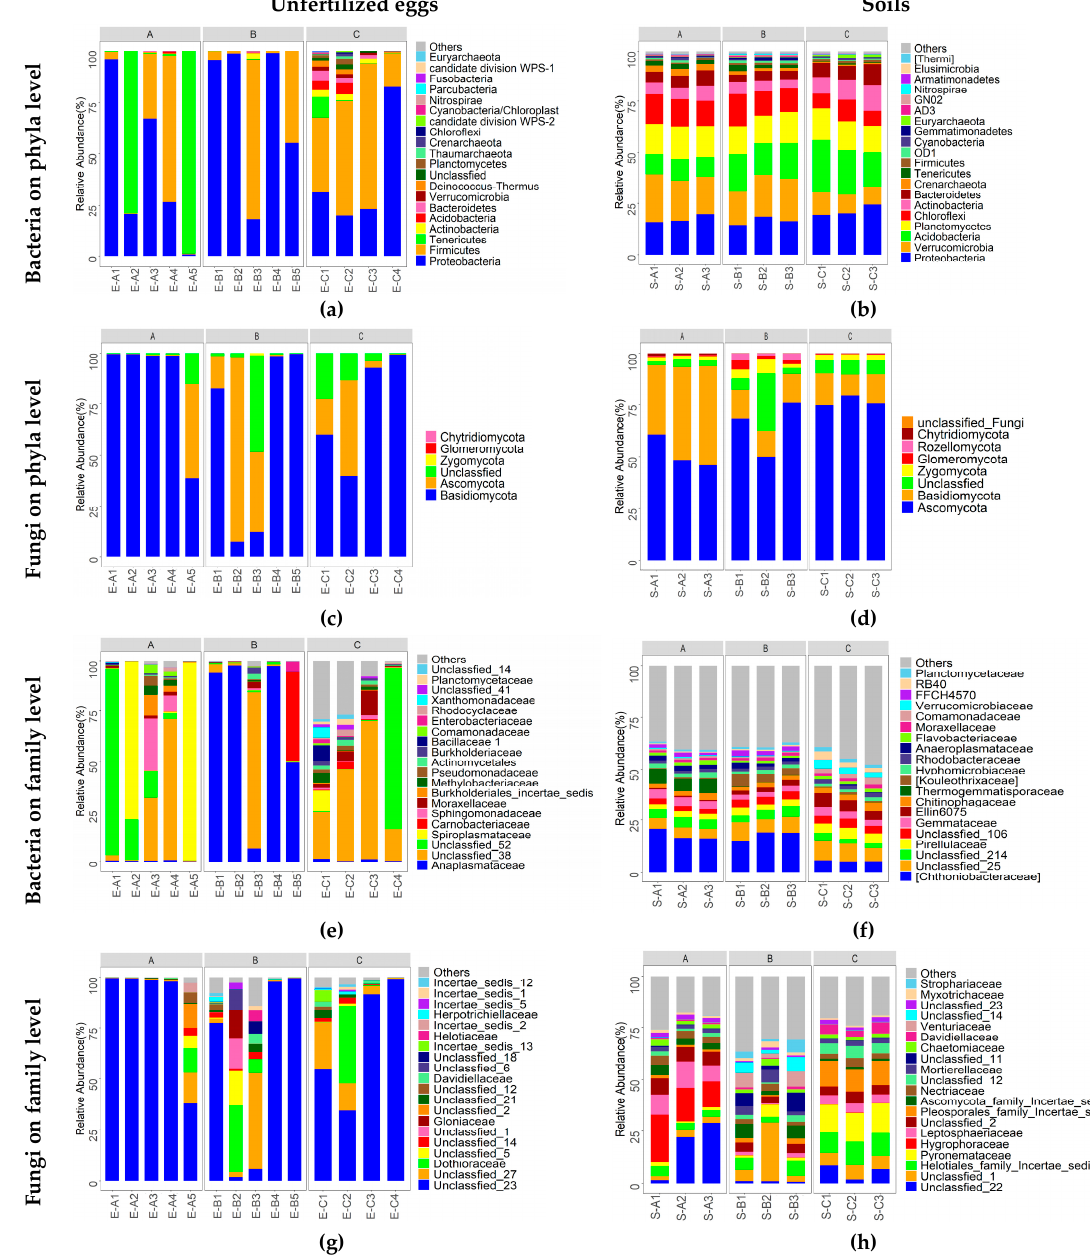
Figure 4. The relative abundances of the top 20 microbial phyla and families in unfertilized eggs ( a , c , e , g ) and soil ( b , d , f , h ) samples at different sites. A, B, and C present different sampling sites with high, low, and null Chinese cordyceps, respectively. Detailed taxa information is presented in Tables A2–A5; “Others” include phyla or families beyond the top 20